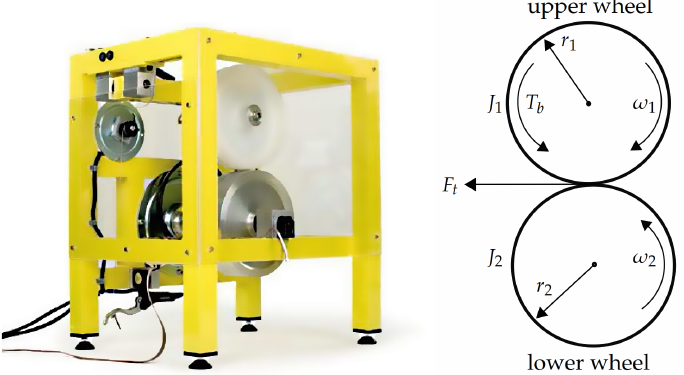
Figure 1. The Inteco experimental setup and its